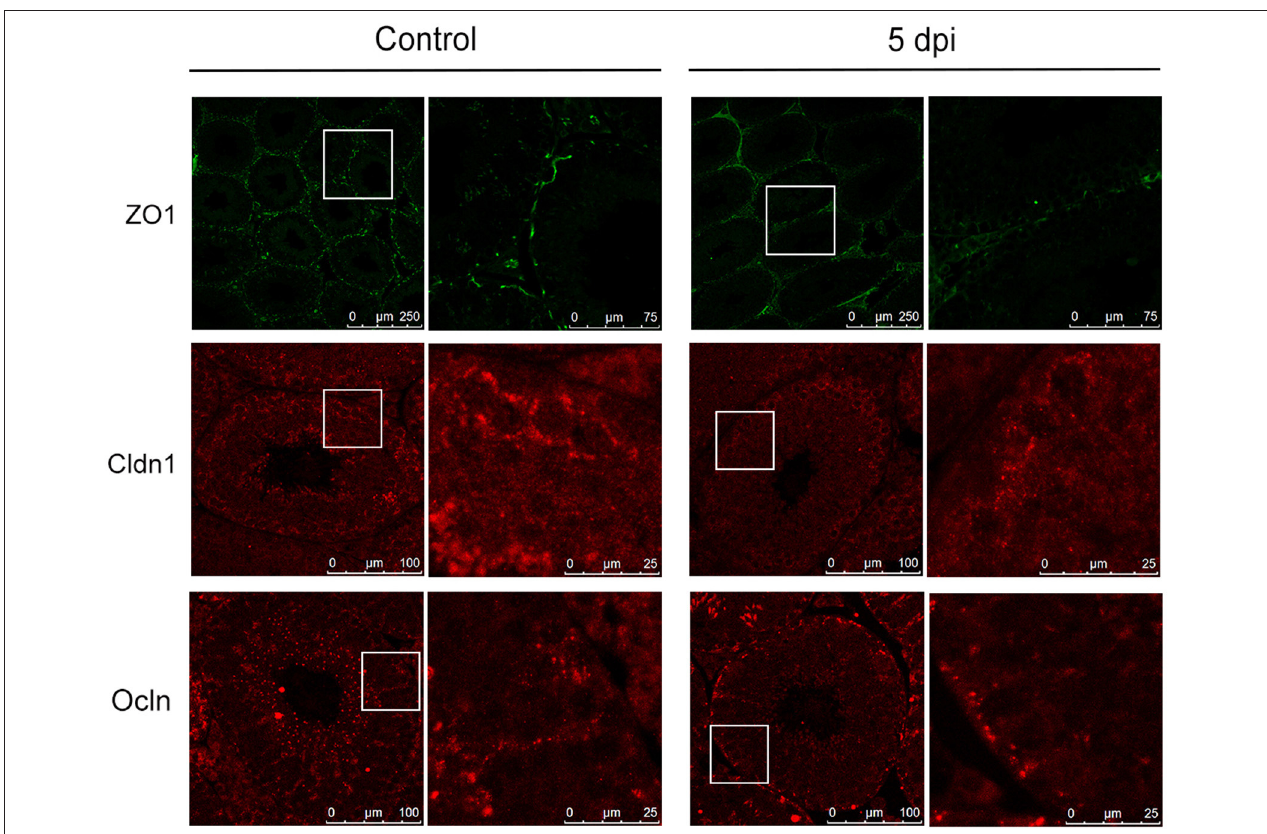
FIGURE 7 | Expression of tight junction associated proteins in testes from mice with or without ZIKV infection. The altered distribution and expression of ZO-1, Cldn1, Ocln in ZIKV-infected testis was analyzed with immunofluorescence staining at 5dpi compared with control